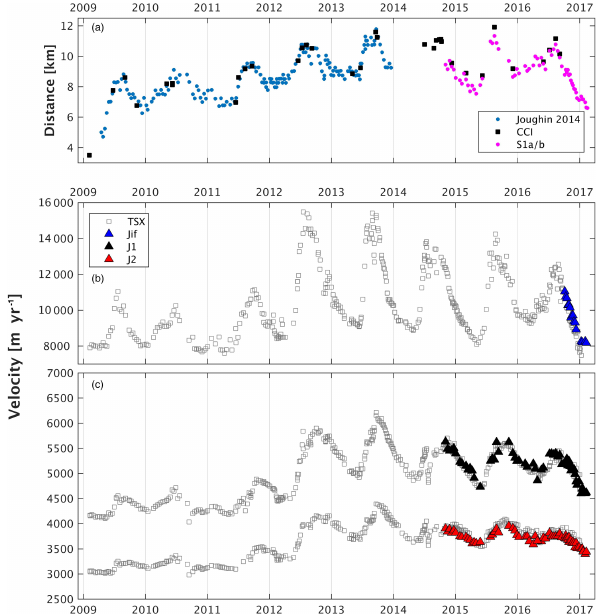
Figure 5. Temporal evolution of Jakobshavn Isbræ (a) ice front position extracted from Joughin et al. (2014), ESA Greenland Ice Sheet Climate Change Initiative (CCI) project (2017), and Sentinel- 1a/b SAR images represented in blue, black, and magenta dots, respectively, where higher values correspond to ice front retreat. Changes in ice velocity through time is also shown (b, c) , extracted at the locations indicated in Fig. 1. The velocity data derived from TerraSAR-X (11 days – Joughin et al., 2016) are shown as grey squares, and the data from Sentinel 1-a/b (6 to 12 days) as coloured triangles.